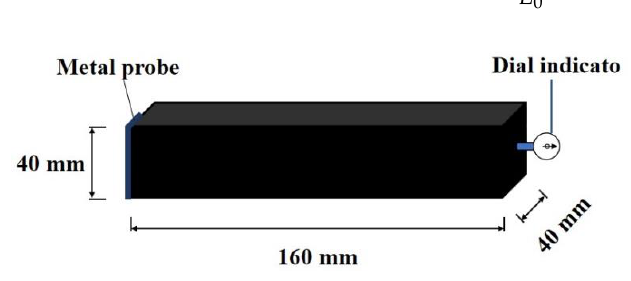
Figure 3. The measurement of drying shrinkage rate.